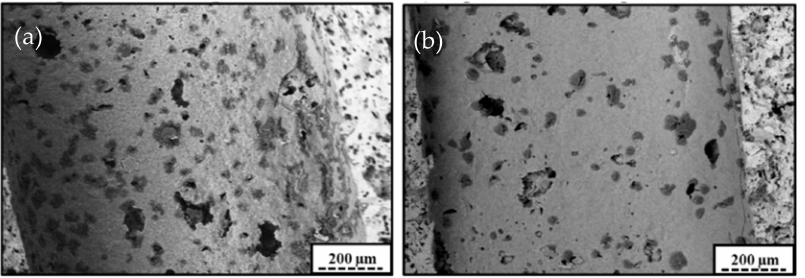
Figure 14. Homogeneous coatings with presence of dark spots: ( a ) sample A-blown, ( b ) sample D. These darker spots were also observed for the solution acidified by nitric acid (Figure